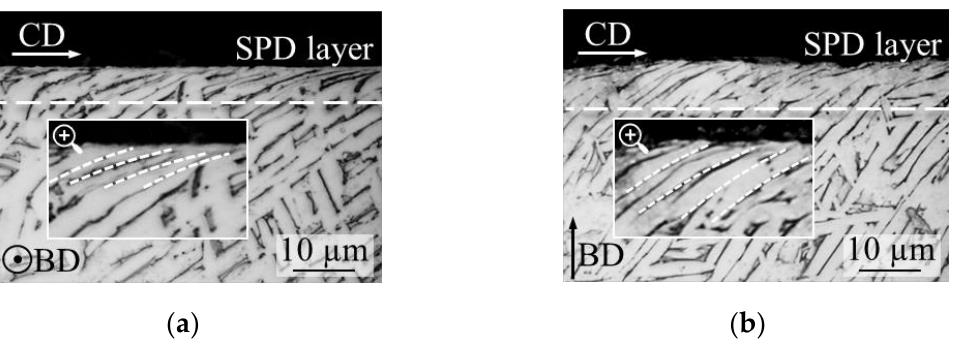
Figure 3. LPBFed Ti6Al4V microstructure of the sample scanned with the stripes strategy and machined under cryogenic condition: cylindrical turning ( a ) and facing ( b ).